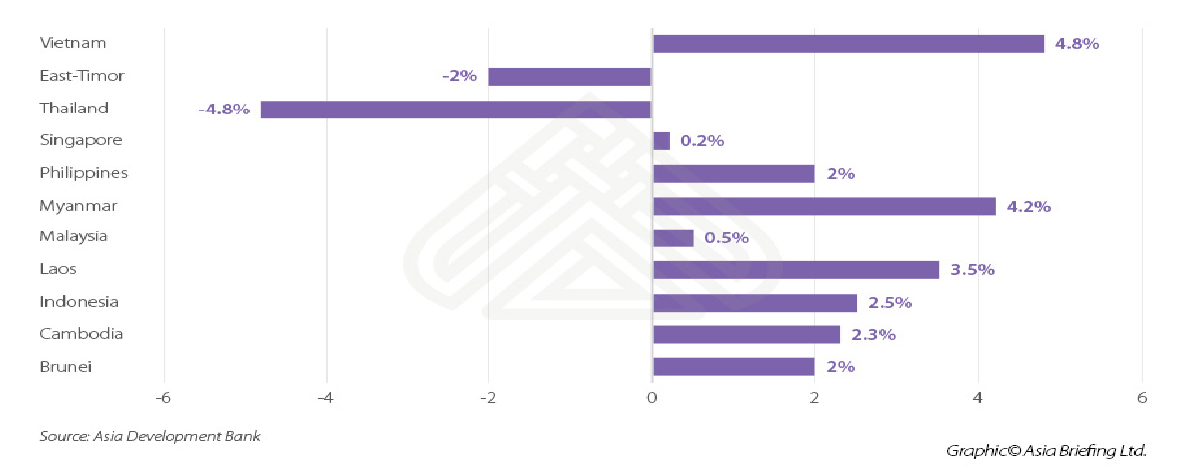
Figure 1: Prediction of GDP Growth Rate in 2020 of Southeast